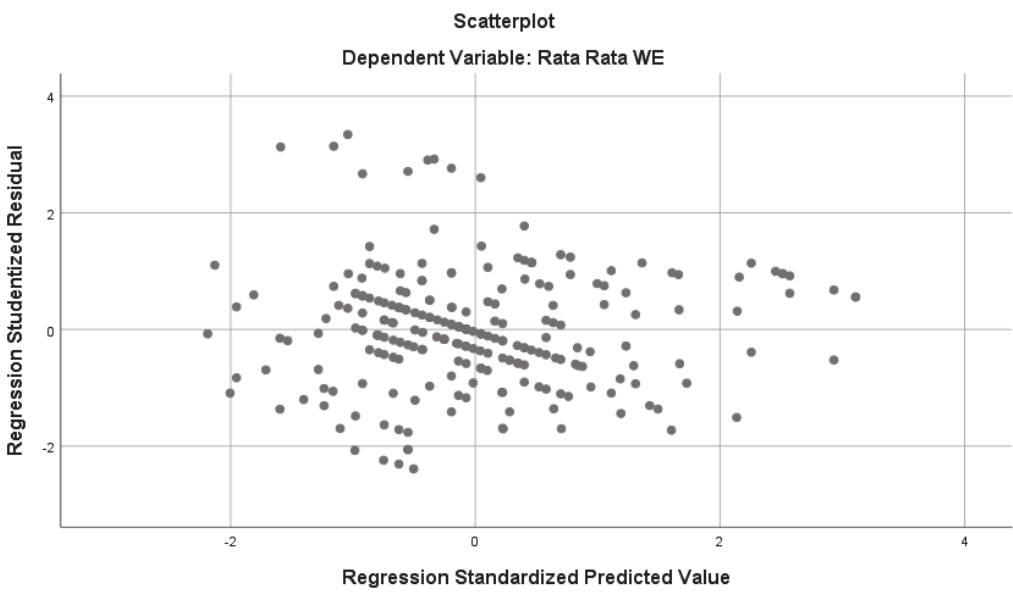
Fig. 4 . Heteroscedacity Test (Scatter Plot